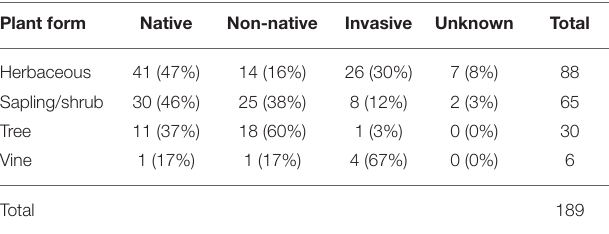
Eleven species occupy both sapling/shrub and tree strata.